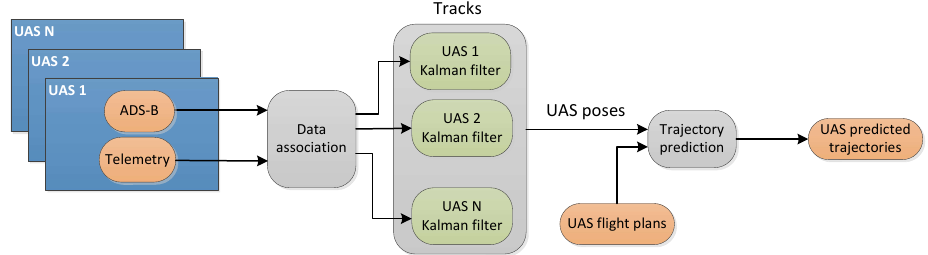
Figure 5. Scheme with the internal components of the Tracking module. The data association compo- nent matches the measurements from the UAS with their tracks, to update the corresponding Kalman filters. The future UAS trajectories are predicted using the tracks and the flight